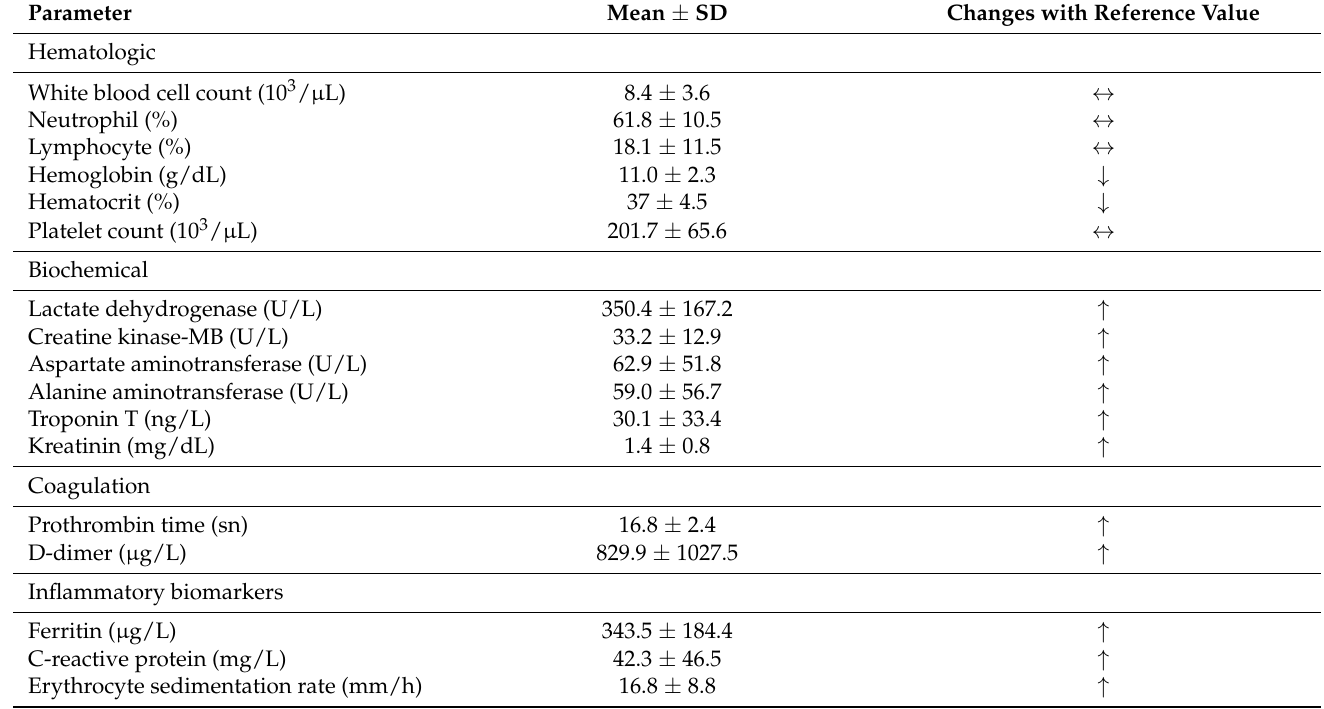
Table 5. Summary of laboratory findings in patients with COVID-19.